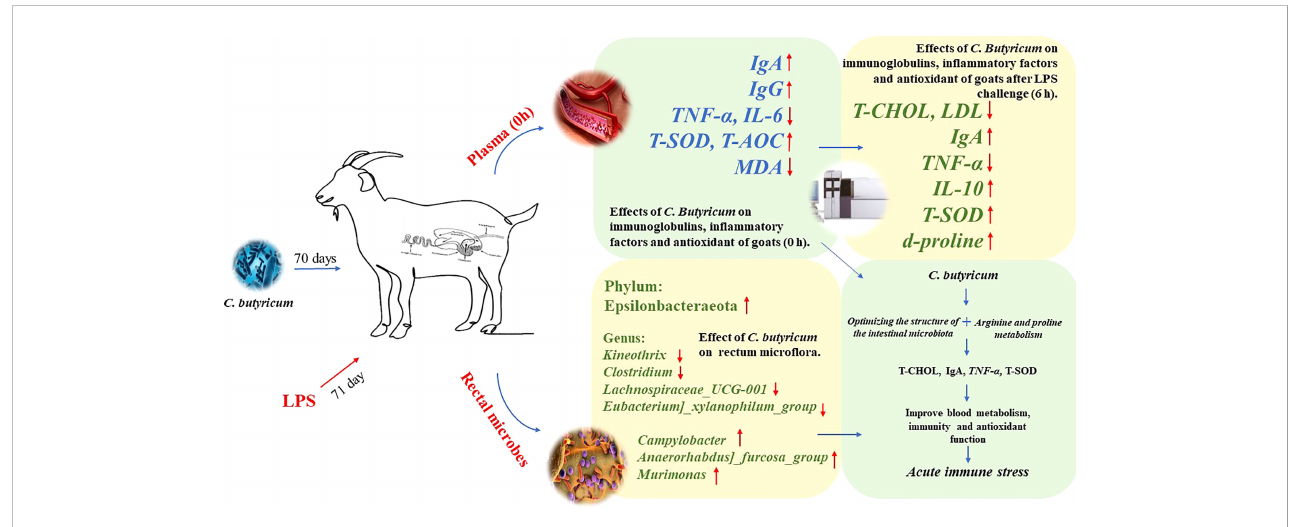
FIGURE 10 Graph abstract: C. butyricum alleviates LPS-induced acute immune stress in goats by regulating bacterial communities and blood